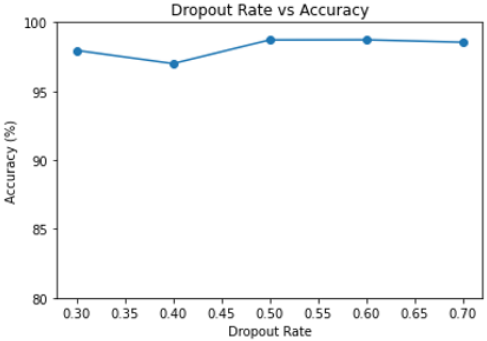
Figure 13. Impact of Dropout Rate on Accuracy.